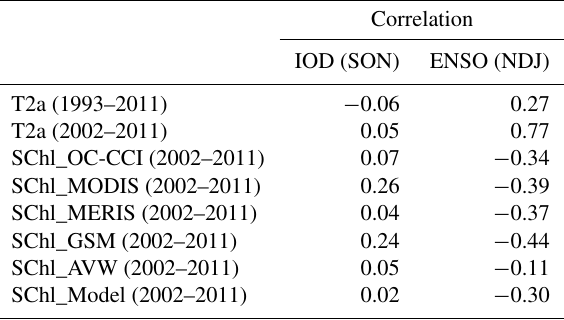
Table 4. Correlation of IOD and ENSO index with interannual anomalies of NAS-box-averaged winter (DJFM) 2m surface tem- perature (T2a) and interannual SChl anomalies derived from differ- ent satellite products and the model. Bold typeface indicates corre- lations which are statistically different from zero at the 90% confi- dence